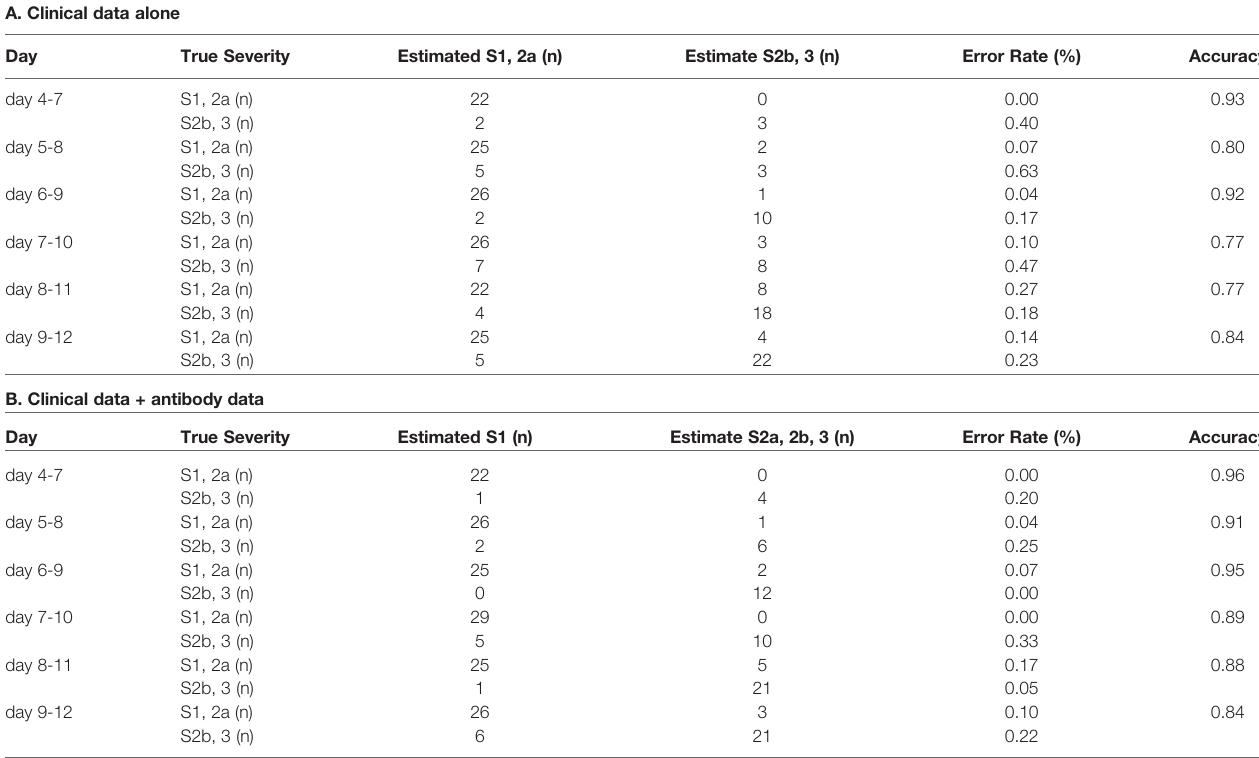
TABLE 2 | The accuracy of the model to distinguish severity groups 2b and 3 from severity groups 1 and 2a in the validation